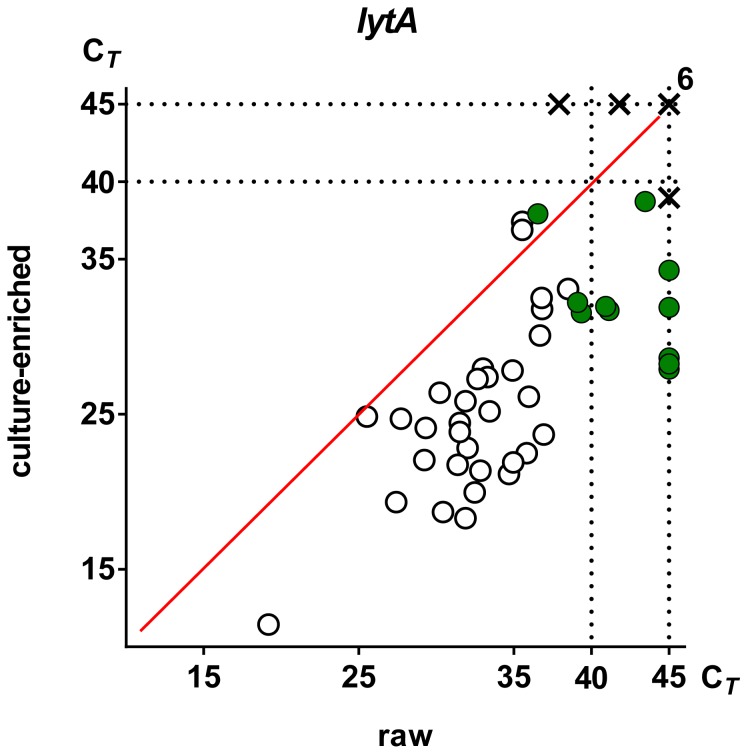
Impact of culture-enrichment on qPCR detection of Streptococcus pneumoniae gene lytA in saliva from schoolchildren.Each dot or cross represents an individual sample. The position of symbols corresponds to CT values for lytA-specific signals in DNA extracted from raw and culture-enriched sample of saliva as marked on corresponding axes. Dots represent 44 samples classified as positive and crosses represent 6 samples classified as negative for S. pneumoniae with qPCR. Open dots represent 32 saliva samples classified as positive for S. pneumoniae in both raw and culture-enriched samples. Green dots represent 12 samples classified as positive only after culture-enrichment. Dotted lines mark the threshold assigned to discriminate between positive (CT <40) and negative samples, and the total number of 45 cycles in each qPCR reaction. There was a significant increase in quantity of both lytA and (not shown) piaA detected with qPCR in culture-enriched compared to raw saliva samples (Mann-Whitney, p = <0.0001).